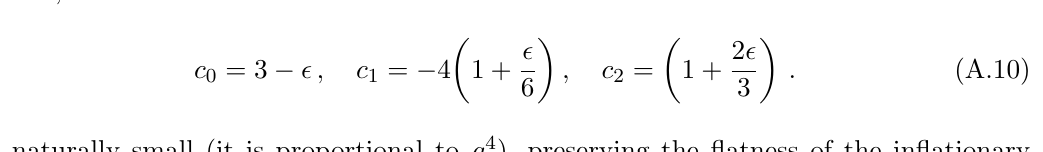
Figure 21 . Left: the (cid:12)bre in(cid:13)ation potential (A.9) in units of V (orange), and (cid:15) = 10 (cid:0) 5 (blue). Right: predictions for the spectral index n s for the three di(cid:11)erent values of (cid:15) (same colour coding as for the potential) as a function of the (cid:12)eld value at horizon exit (cid:30) (cid:3) . Di(cid:11)erent values of (cid:30) (cid:3) correspond to di(cid:11)erent numbers of e -folds of slow-roll in(cid:13)ation N (cid:3) . The value of N (cid:3) ranges from 50 (tiny dot) to 60 (large